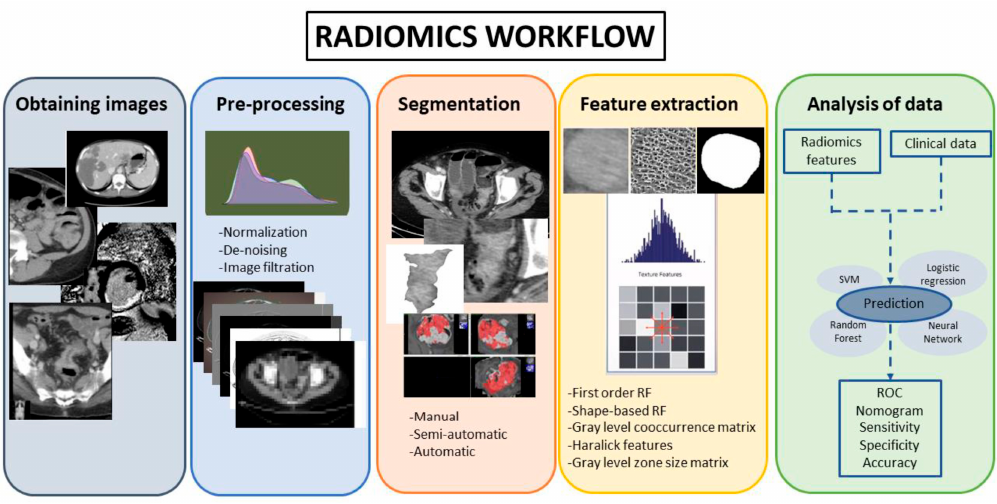
Figure 3. Radiomics workflow.